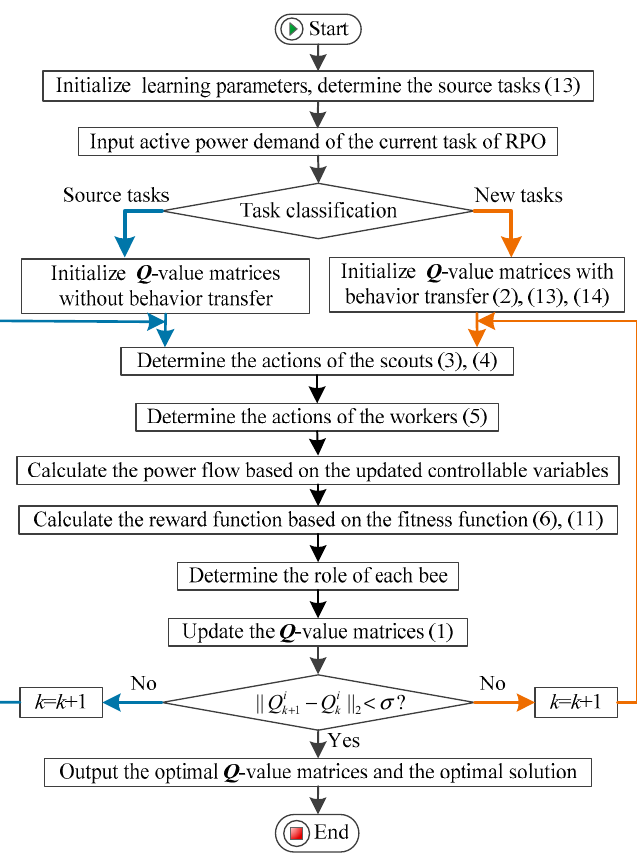
Figure 4. Flowchart of TBO for reactive power optimization (RPO).